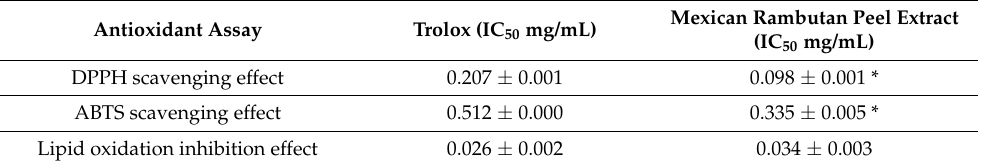
Table 2. The antioxidant activity of Mexican rambutan peel extracts expressed as IC 50 , (*) indicates significant differences ( p < 0.05) between Trolox and Mexican rambutan peel extract. Statistical analysis performed was made to compare the results of the extract against a known antioxidant such as Trolox.